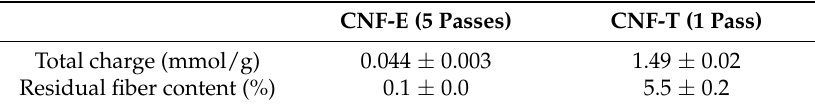
Table 2. Carboxyl group content based on conductometric titration and residual fiber content calculated using data from fiber analysis (L&W Fiber tester plus). The number of passes during microfluidization is presented in brackets for the two CNF